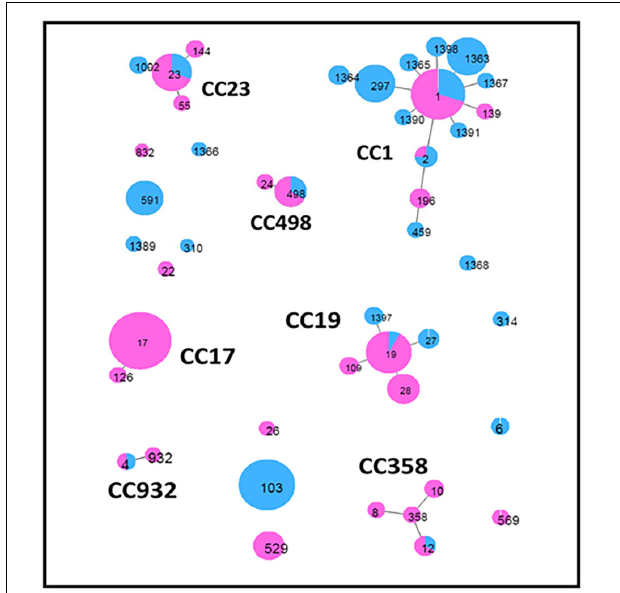
FIGURE 2 | Minimum spanning tree obtained by global eBurst analysis using PHYLOVIZ software. This shows the distribution of host species across clusters of Streptococcus agalactiae sequence types (STs) obtained in the present study. Each circle represents an ST. The size of the circle and its colored segments are proportional to the number and origin of isolates, where pink refers to humans and blue refers to bovines, respectively. Clusters, including single- and double-locus variants, are indicated by the corresponding clonal complex